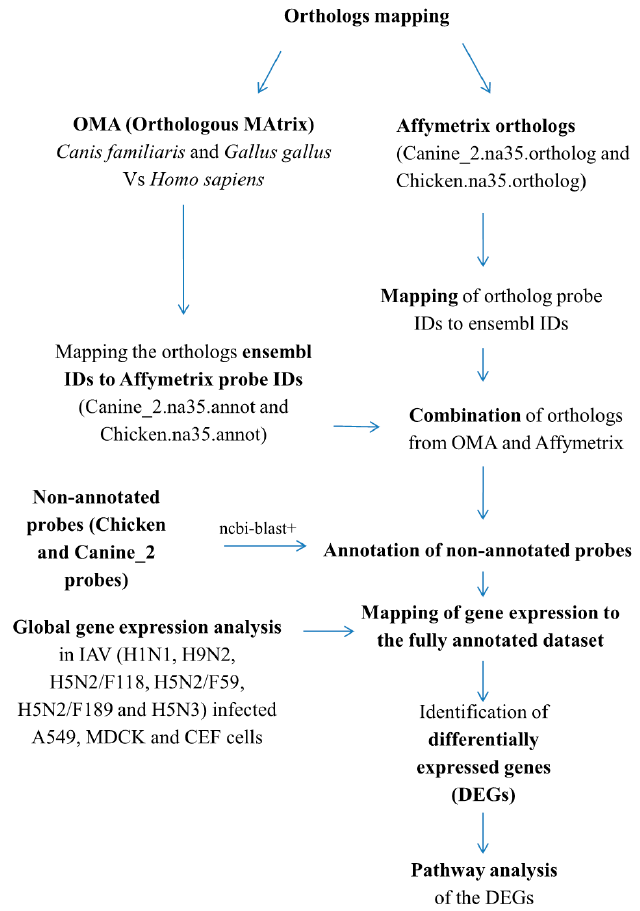
Figure 1. Overview of Affymetrix probe annotation and orthologs mapping. IDs = identifications, OMA = “Orthologous Matrix” database.